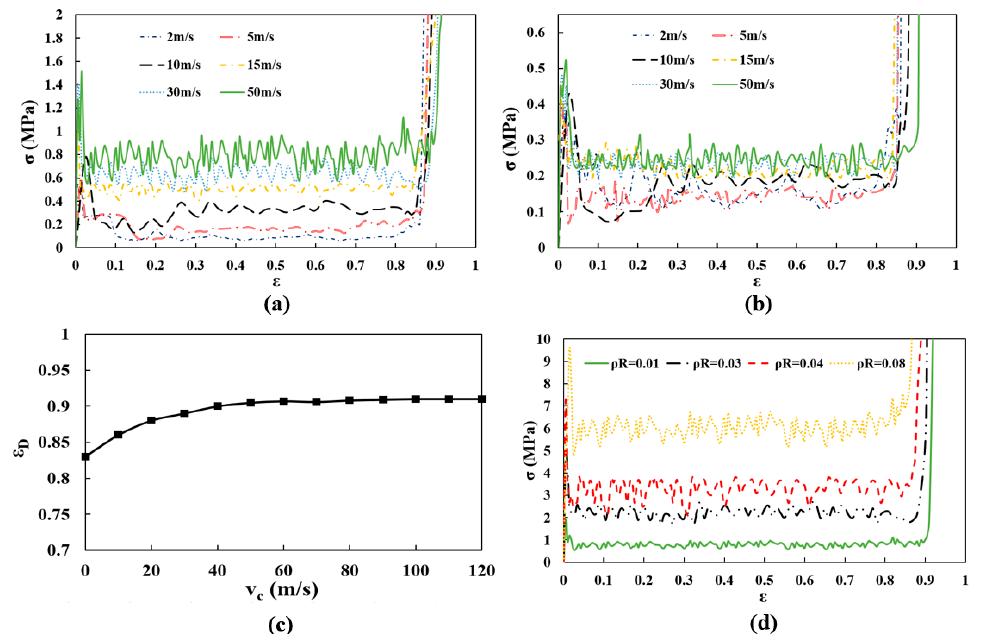
Figure 9. Dynamic crushing strength of the 3D re-entrant auxetic structure: ( a ) Crushing stresses at the proximal end; ( b ) Crushing stresses at the distal end; ( c ) Dynamic densification strains ε D under different crushing velocities; ( d ) Crushing stresses (proximal end) of structures with different relative densities.